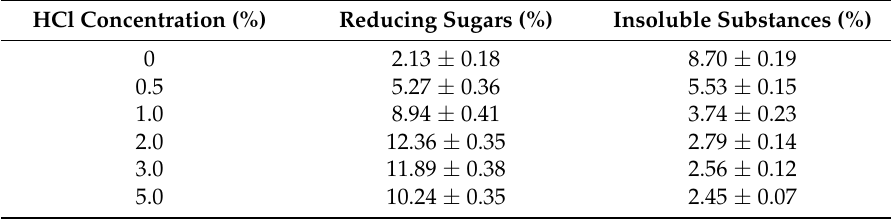
Table 1. Reducing sugar and insoluble substance content of HCl hydrolyzed